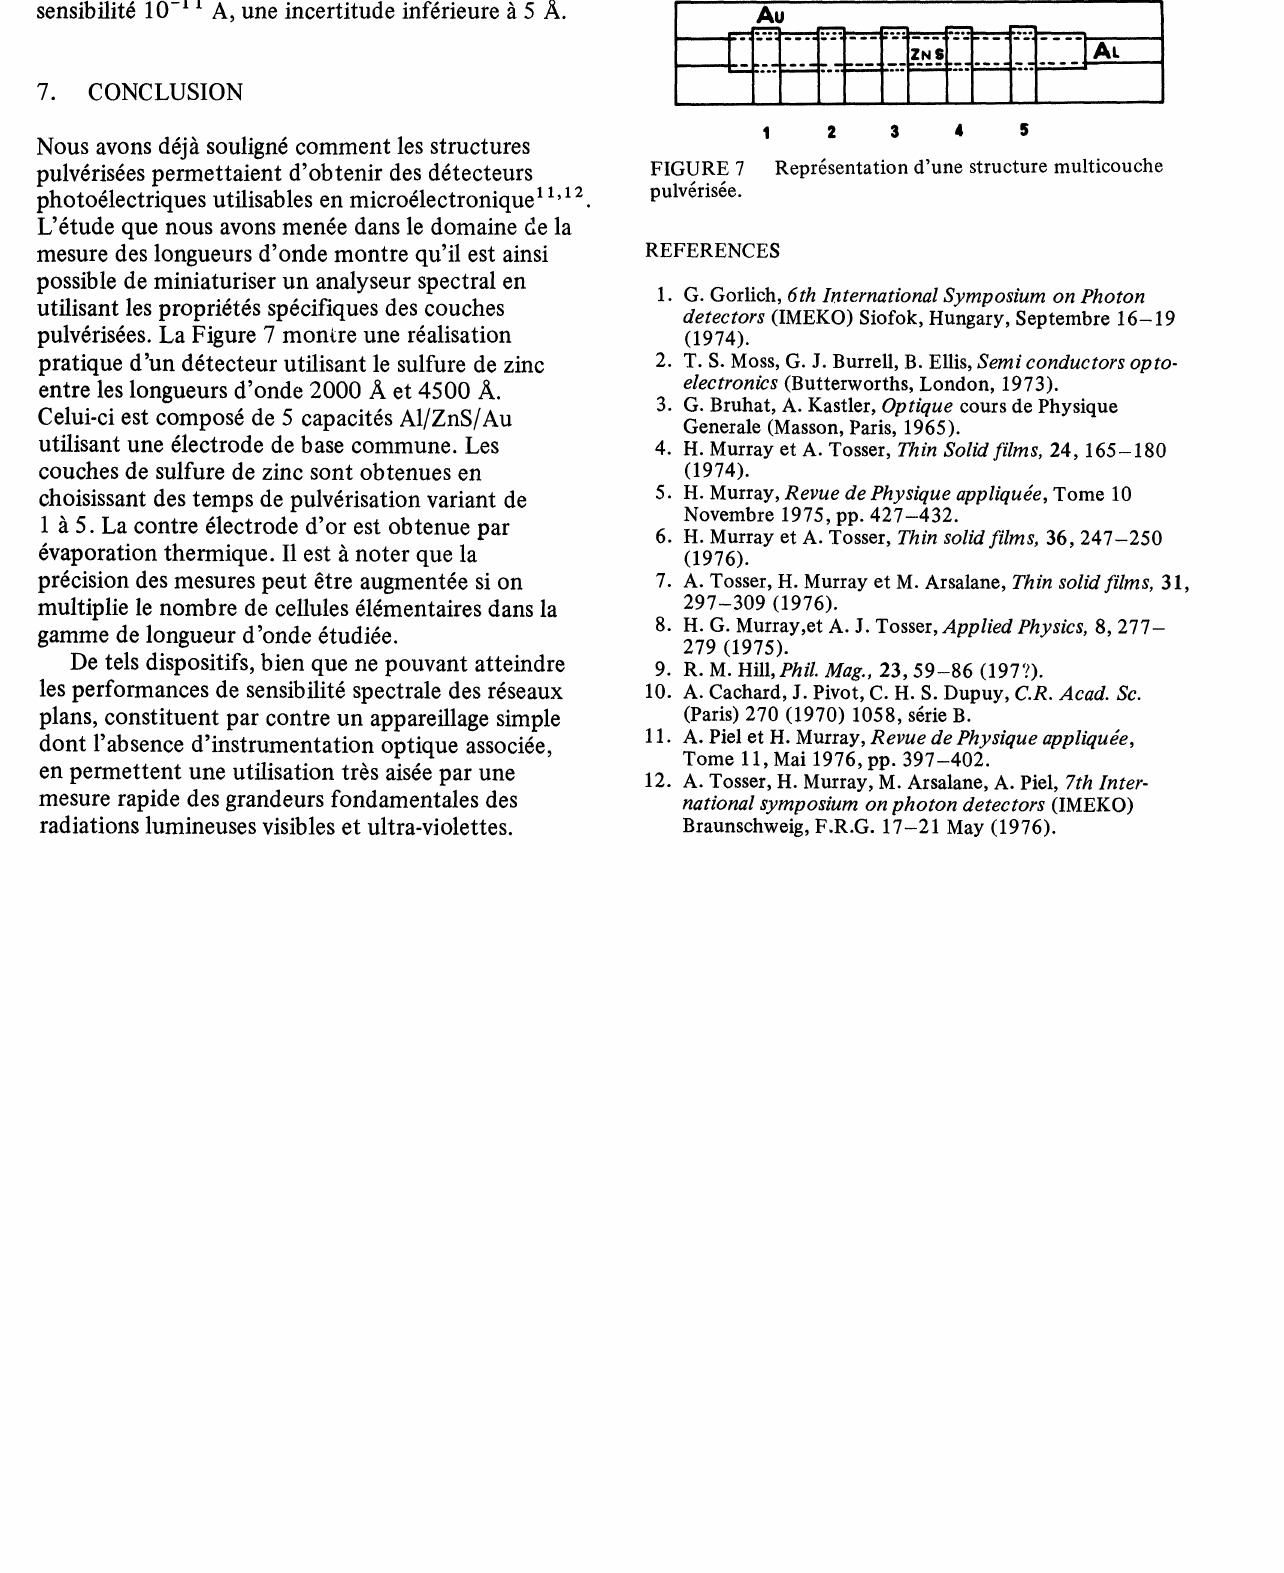
FIGURE 7 Representation d’une structure multicouche